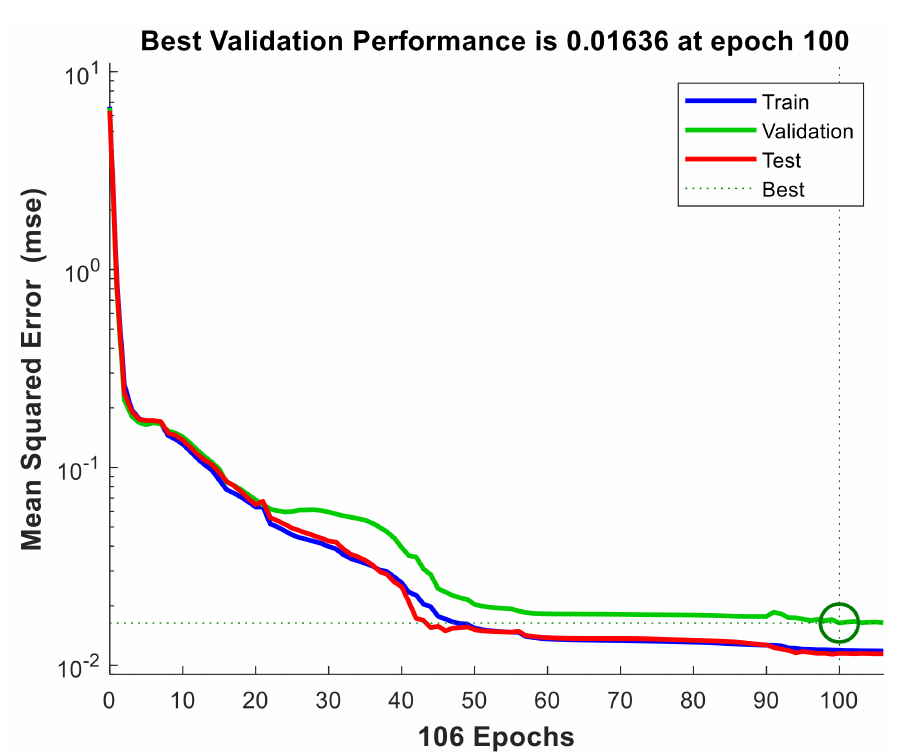
Figure 10. Number of epochs vs. mean square error for the instantaneous gas injection model.